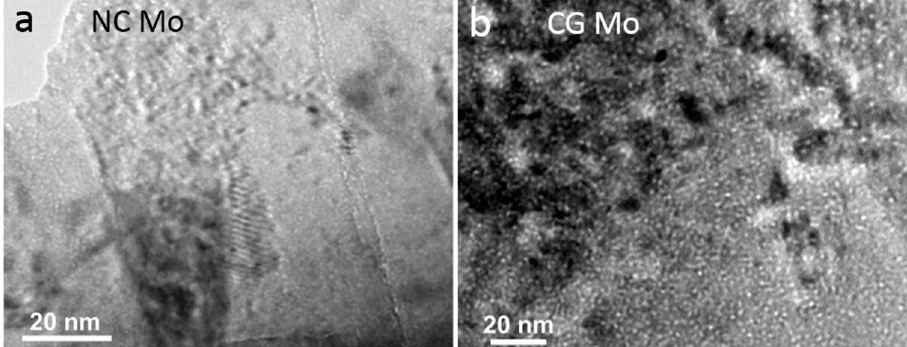
Figure 8. He bubbles induced by He irradiation in: NC Mo ( a ); and CG Mo ( b ) [83]. Small He bubbles with an average size of 0.6 nm are observed in NC Mo, while large He bubbles with an average size of 1.2 nm are identified in CG Mo. Reprinted with permission from [83]; Copyright 2016 Elsevier.